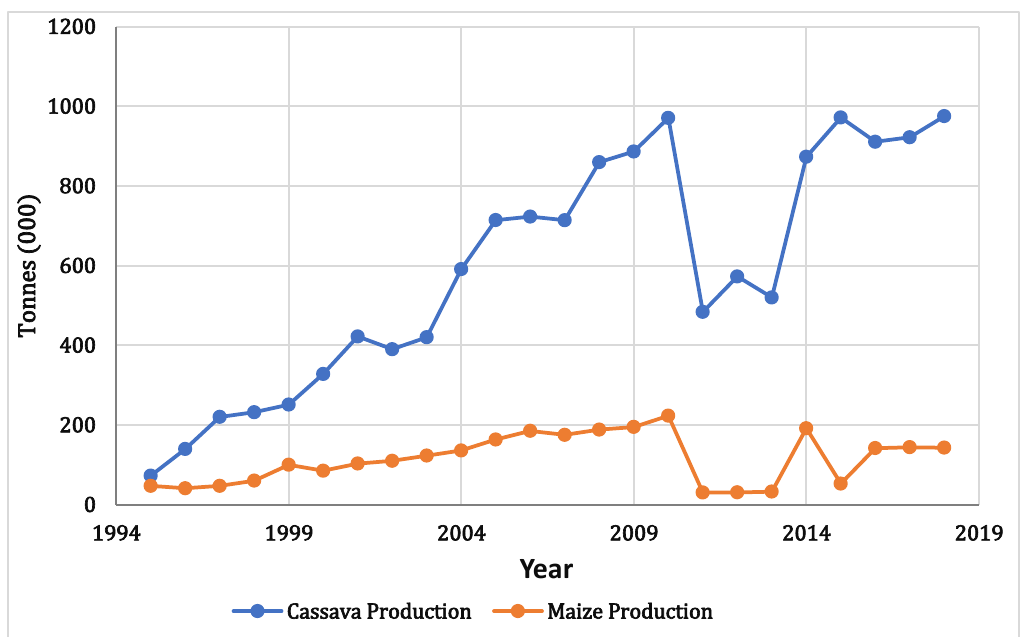
Figure 4. Lagos Cassava and Maize production through time (1995 – 2018).